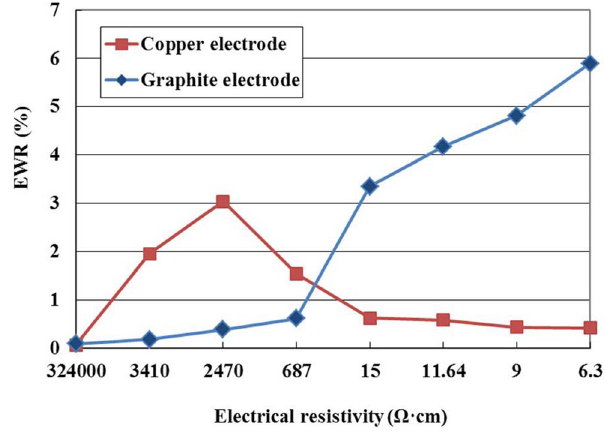
Figure 13. Effect of the electrode material on EWR.